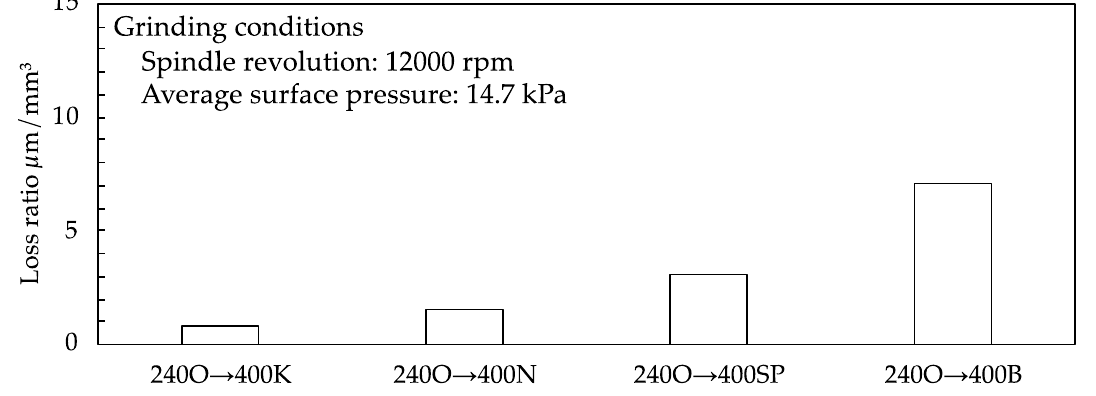
Figure 13. Loss ratios of the steel sheet after the semi-finish grinding.